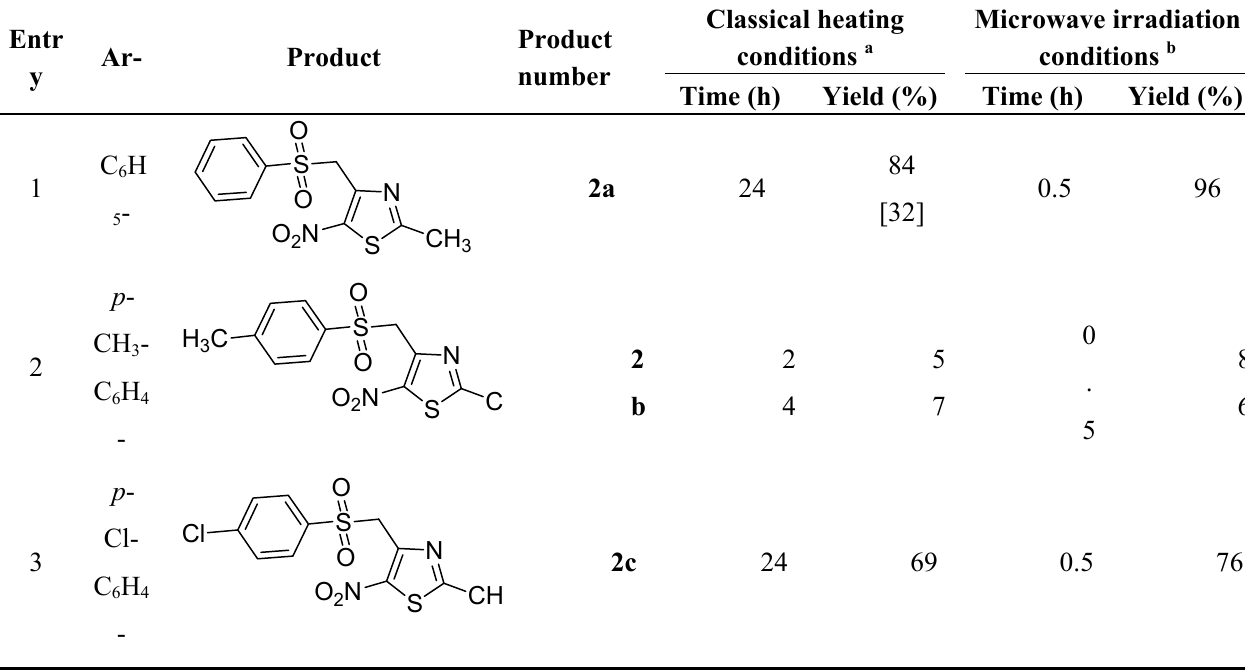
Table 1. Classical heating method versus microwave-assisted synthesis of sulfones 2a to 2c . Classical Product Entr Product